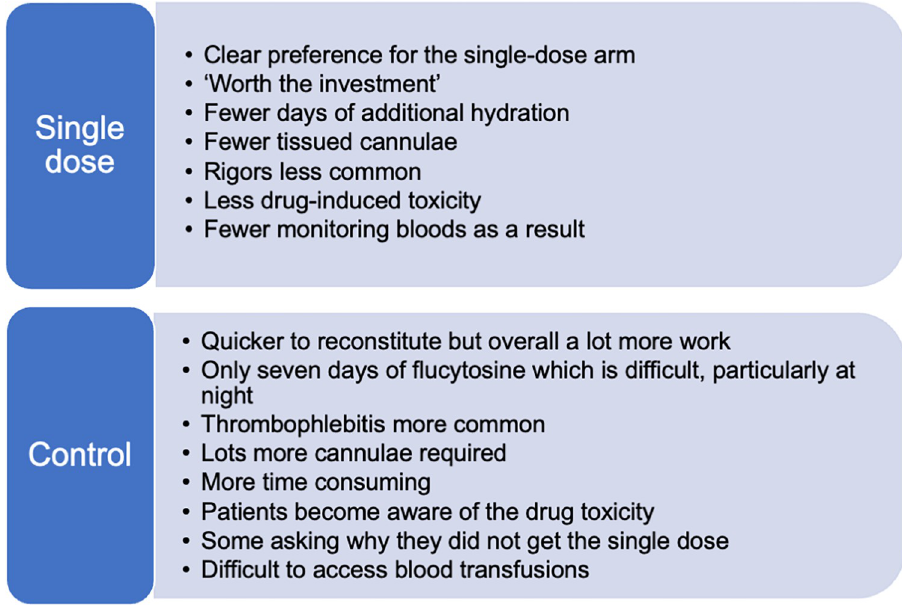
Fig 2. Feedback on the administration and toxicity of the two treatment